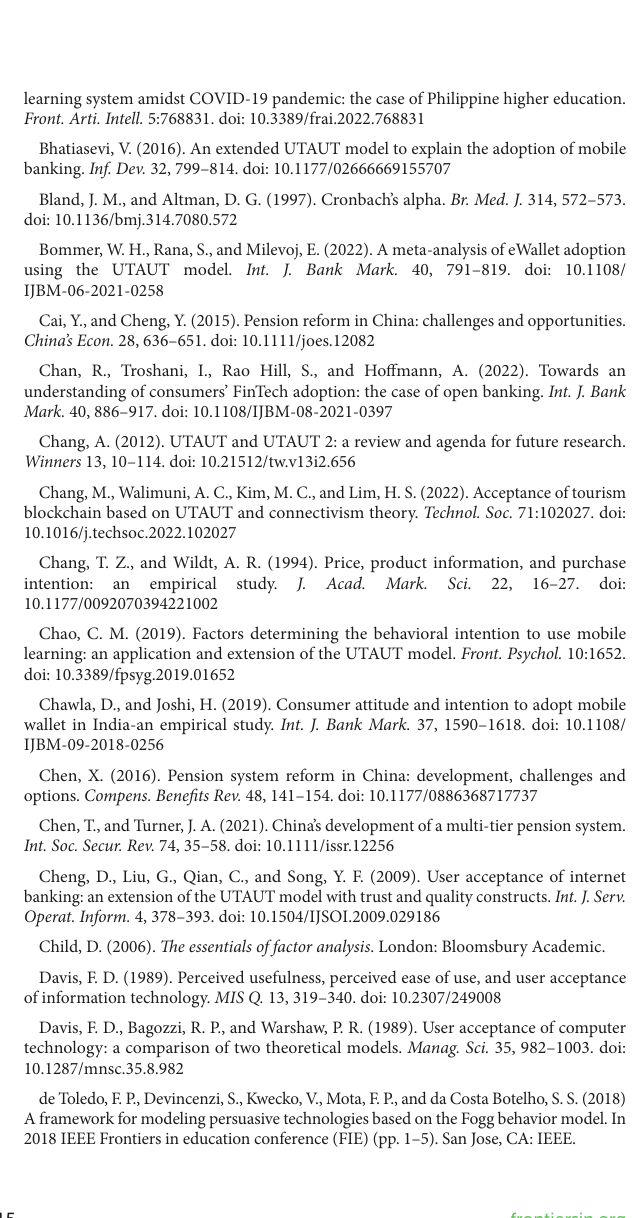
SUPPLEMENTARY TABLE A1 The items of questionnaire. SUPPLEMENTARY FIGURE A1 The SEM